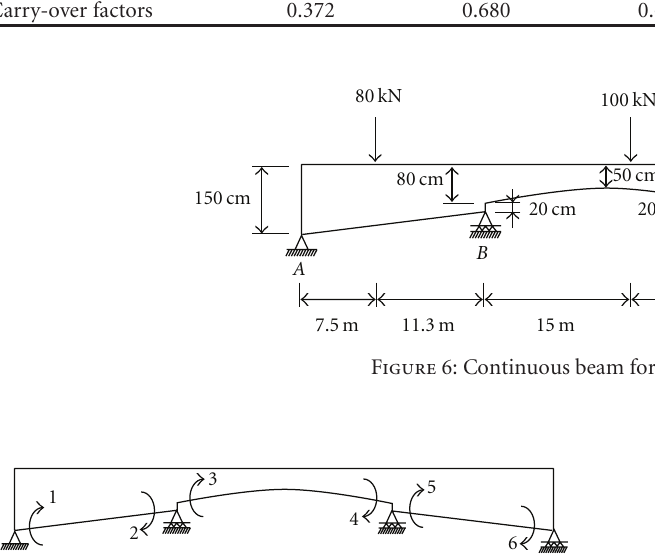
Figure 7: Reference coordinates for the second